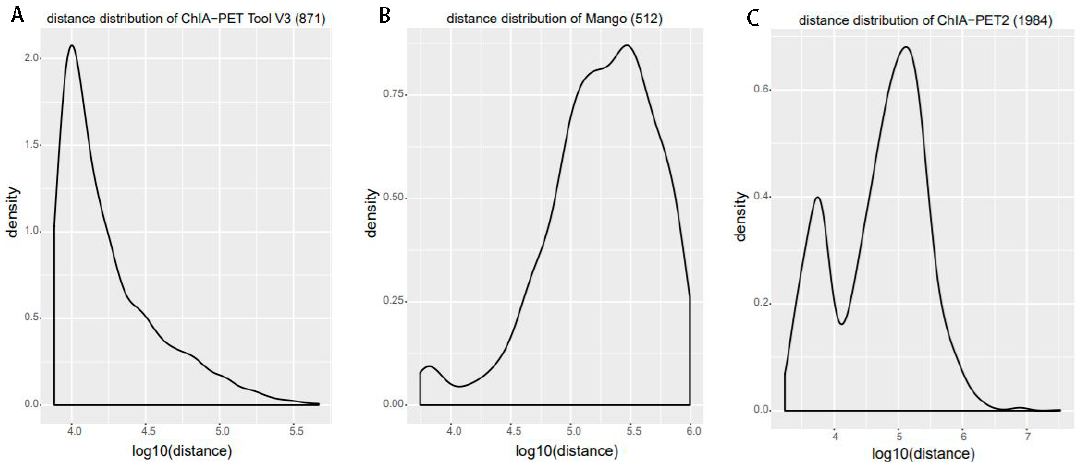
Figure 13. Genomic proximity of the subset interactions unique to each tool. ( A ) Distance distribution of the unique interactions from ChIA-PET Tool V3. ( B ) Distance distribution of the unique interactions from Mango. ( C ) Distance distribution of the unique interactions from ChIA-PET2.